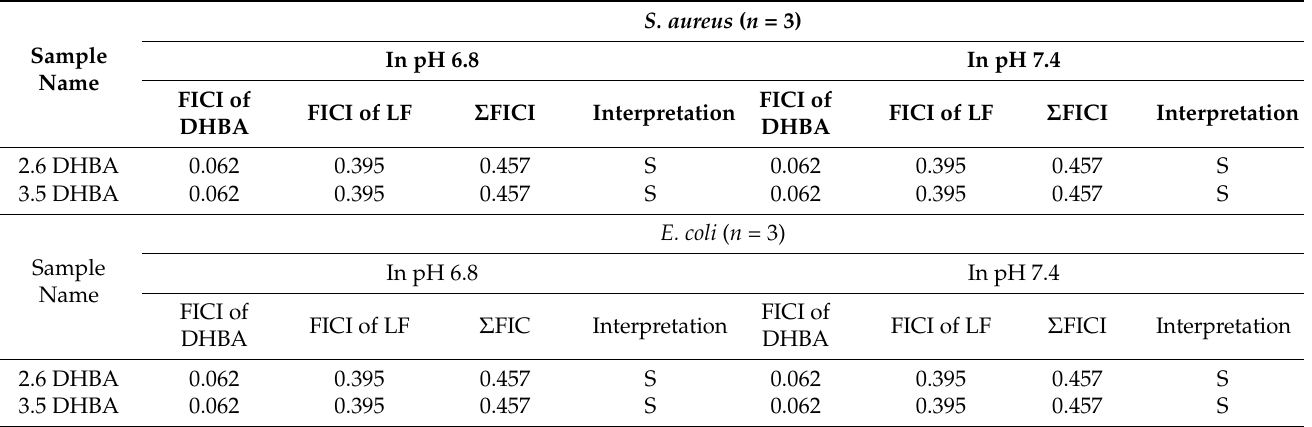
Table 6. Fractional inhibitory concentration index (FICI) for the combination of LF with 2,6 DHBA and 3,5 DHBA against Staphylococcus aureus and Escherichia coli